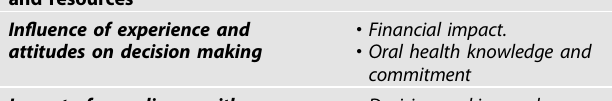
Table 1. Core statement and supportive key statements of the results. ´To fi nd a balance between attitudes, compliance with guidelines and resources´ In fl uence of experience and attitudes on decision